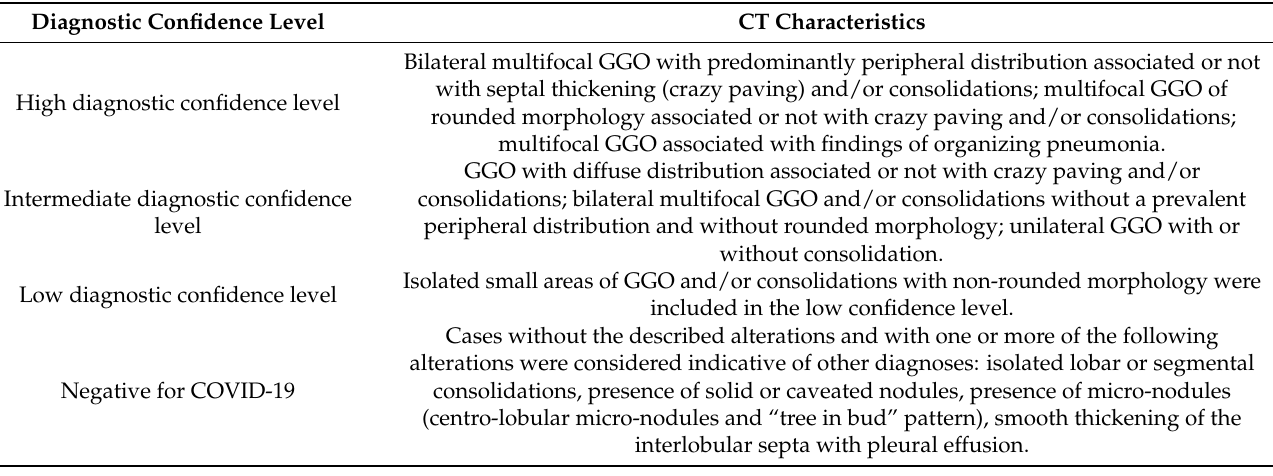
Table 2. CT findings considered for assignment of the diagnostic confidence